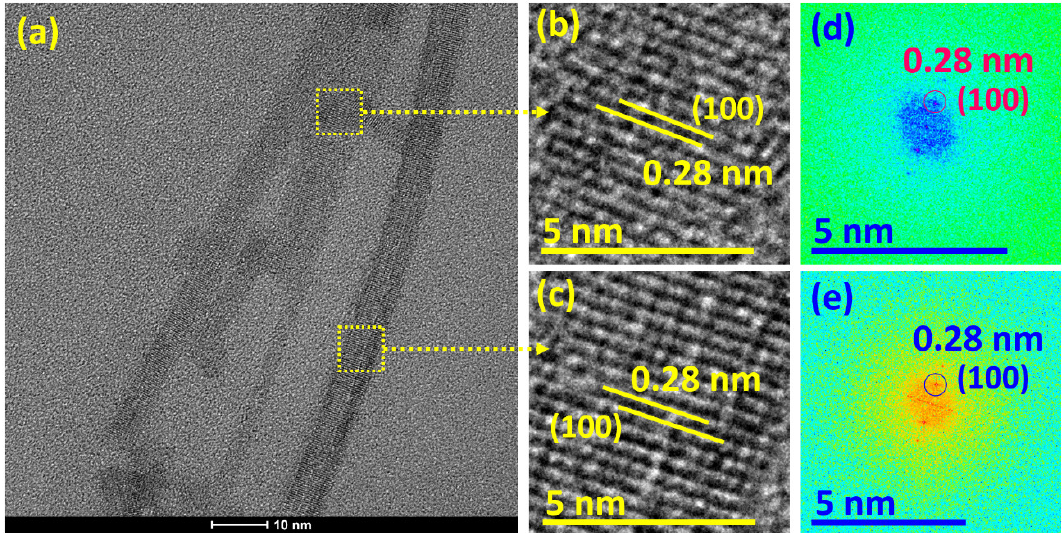
Figure 3. ( a ) HRTEM image, ( b , c ) magnified HRTEM images, and corresponding ( d , e ) FFT patterns of the WS 2 nanorods.